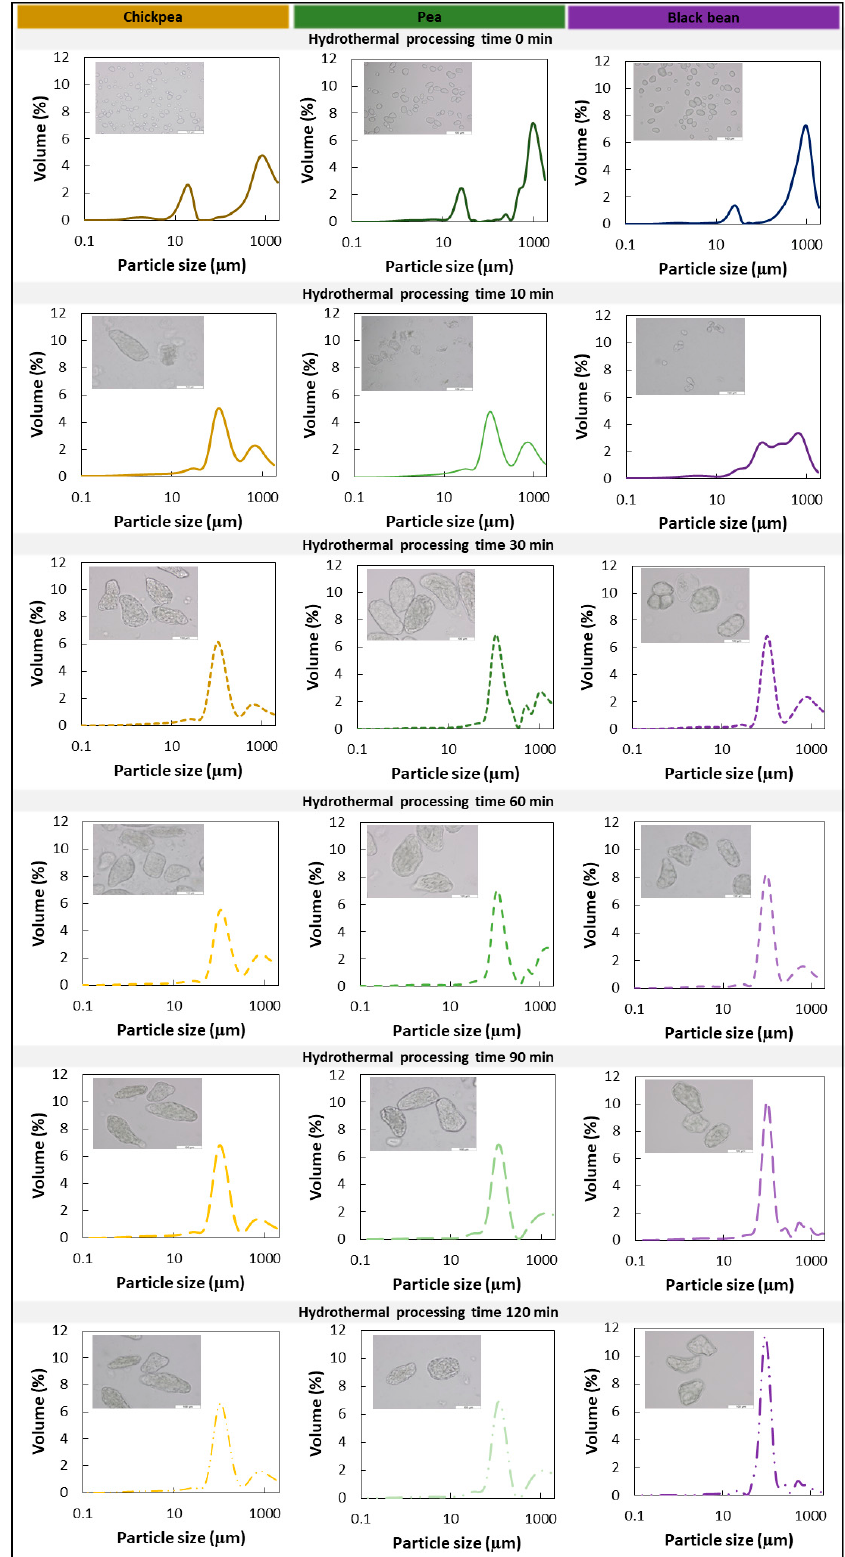
Figure 2. Volumetric particle size distributions and representative microscopic images (scale bar: 100 µ m) of whole seed material from hydrothermally treated and mechanical disintegrated chickpea (yellow), pea (green), or black bean (purple) using different processing times (95 ◦ C, t: 0–120 min). Means of triplicate evaluations are